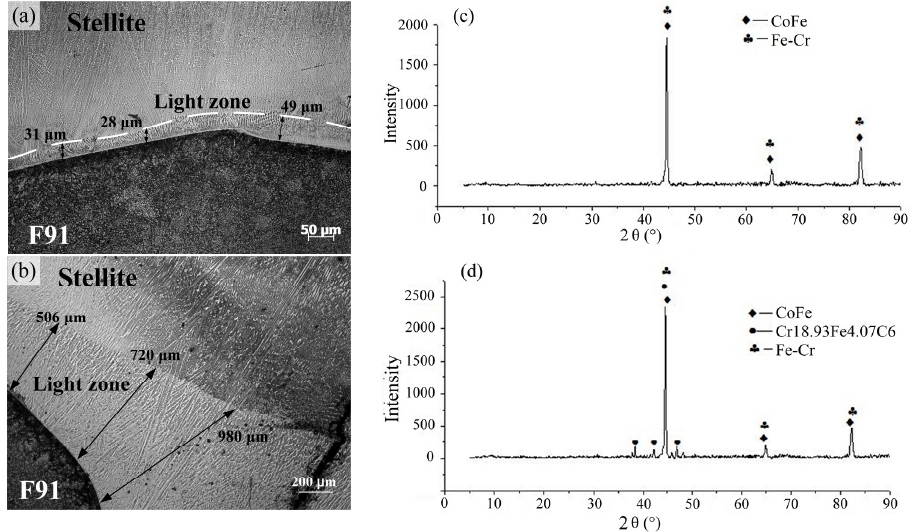
Figure 3. The interface between Stellite 6 and F91 steel of samples ( a ) #1 and ( b ) #2; The X-ray diffraction (XRD) results of phases in ( c ) fusion zone of sample #1 and ( d ) light zone of sample #2.